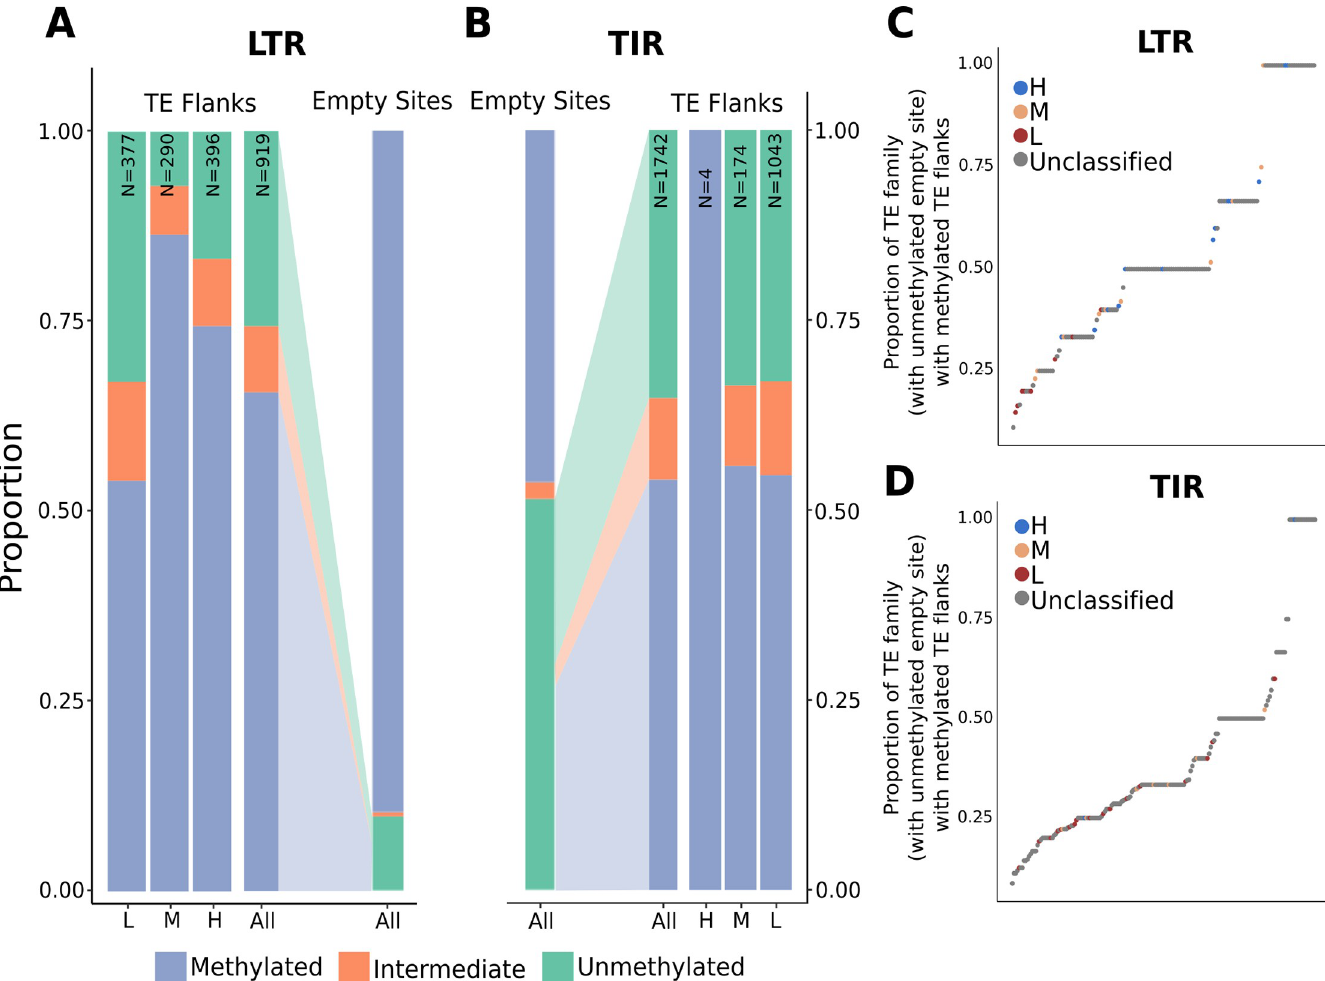
Fig 7. Analysis of CG DNA methylation changes induced by TEs. (A-B) The subset of TEs that are located within CG unmethylated empty sites could assessed for changes in levels of CG methylation in flanking regions. There are 919 LTR elements (A) and 1742 TIR elements (B) that represent insertions into unmethylated empty sites for which there is CG methylation data for the regions flanking the TE. The proportion of these TEs that show methylation, based on the average CG methylation of the TE flanks, was determined for all of these sites as well as the subsets that are near TEs belonging to families classified as having H, M or L flanking CG and CHG methylation. For the set of LTR (C) or TIR (D) families that have at least four insertions into CG unmethylated regions, the proportion of family members that gain CG DNA methylation was determined and used to rank order the families. Each family was color coded based on it’s classification for H, M or L flanking methylation. The unclassified families did not have enough elements to be classified as H, M, or